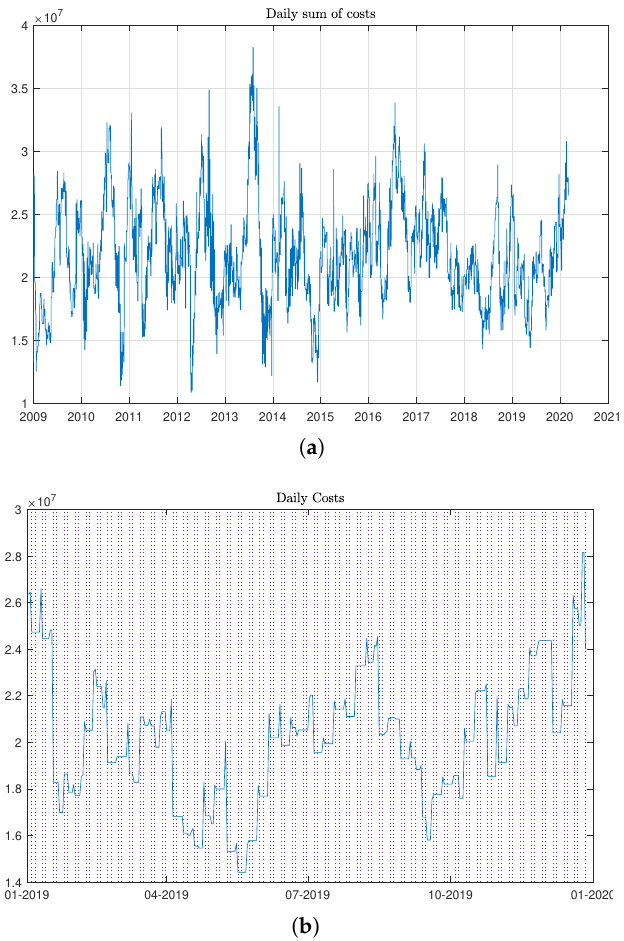
Figure 8. Series of aggregate daily costs c t , over the whole period 2009–2020, panel ( a ), and in 2019, panel ( b